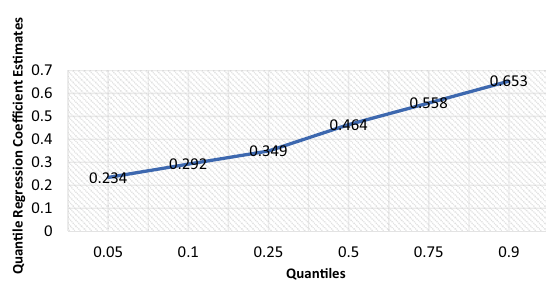
Fig. 11 Plot of coefficients of quantile regression for MIL and RGDPPCP